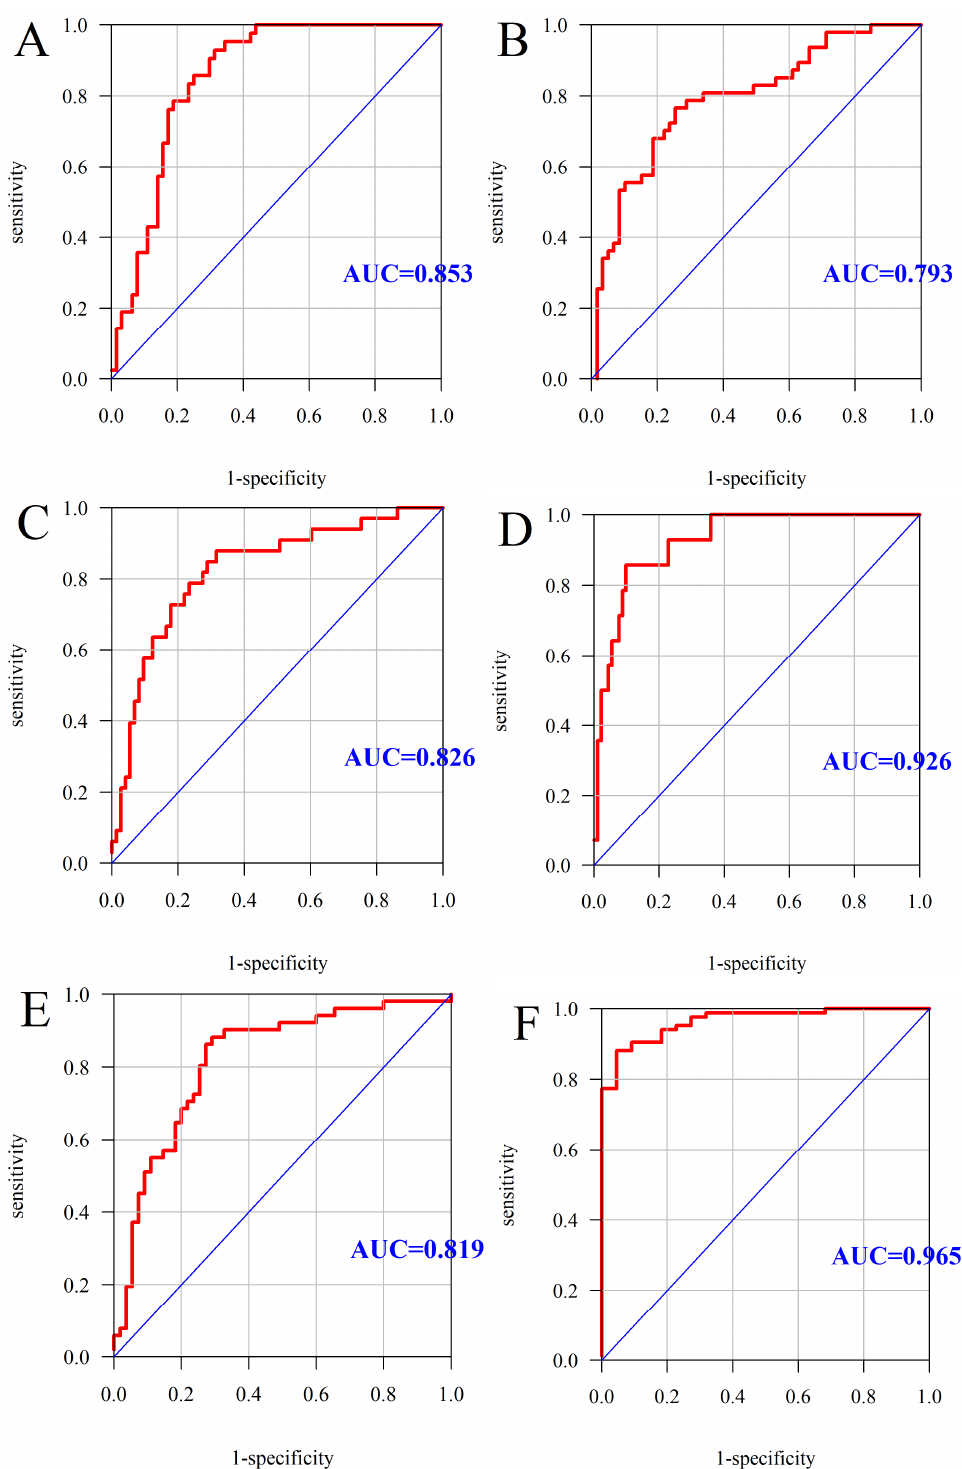
Figure 1. ROC curve and AUC value: MS ( A ), triglycerides > 150 mg/L ( B ), HDL < 50 mg/dL ( C ), glucose ≥ 100 mg/dL ( D ), blood pressure > 130/85 mmHg ( E ), abdominal obesity ( F ). AUC—Area Under the Curve (measure of diagnostic